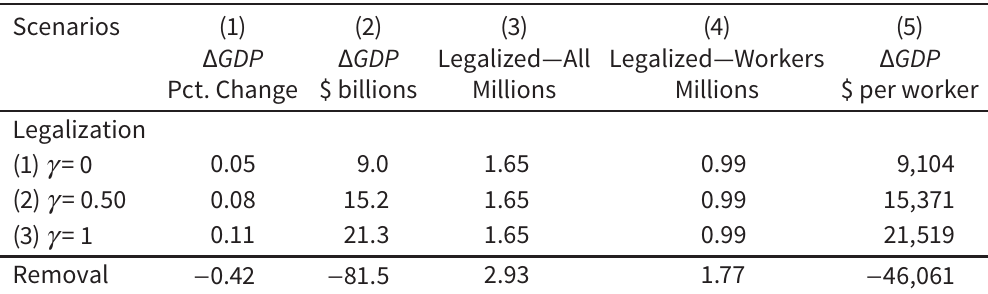
Long-run Effects of the DREAM Act on